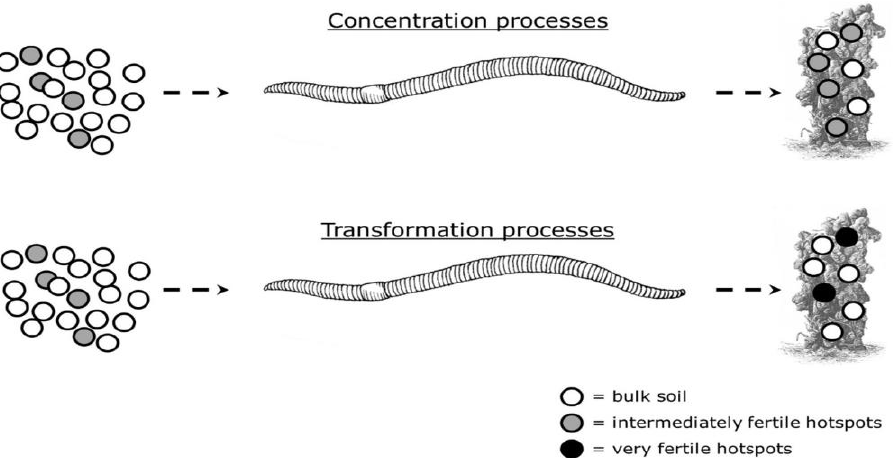
Figure 2. A theoretical representation of the processes by which the fertility of EWs casts is increased through (i) the concentration of existing fertility pools in the soil and (ii) the transformation processes during gut transit, leading to new pools of fertility. Reprinted from ref. [54], with permission from Elsevier.